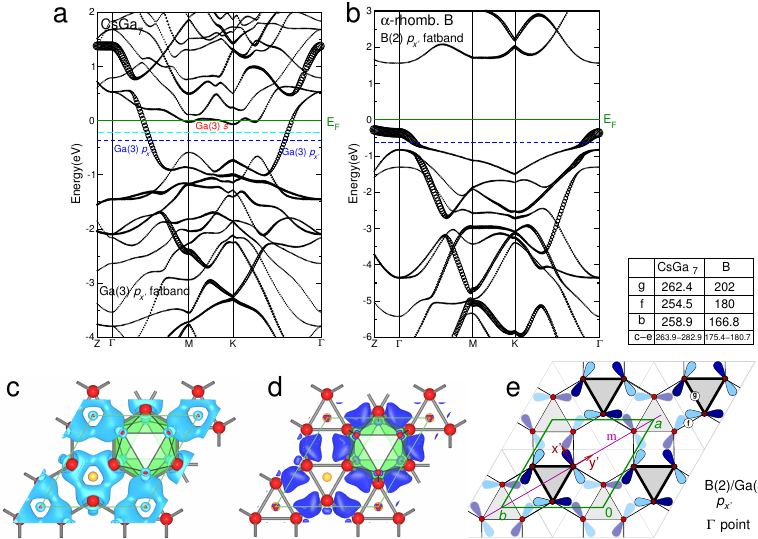
Figure 5. Comparison of the band structures of CsGa (( a ), Ga(3)- p x (cid:48) fatband plot) and α -rhombohedral 7 boron (( b ), B(2)- p x (cid:48) fatband plot); ( c , d ): E -selected ρ maps ( − 0.23 to E F and − 0.23 to − 0.36 eV, cf. the cyan and blue line in the band structure plot ( a )) within the 3.4.6.4. net of Ga(3)/B(2) atoms together with ( e ) a schematic illustration of the Ga(3)- p x (cid:48) orbital bonding contribution at the Γ point (please note the local coordinate (cid:48) system for